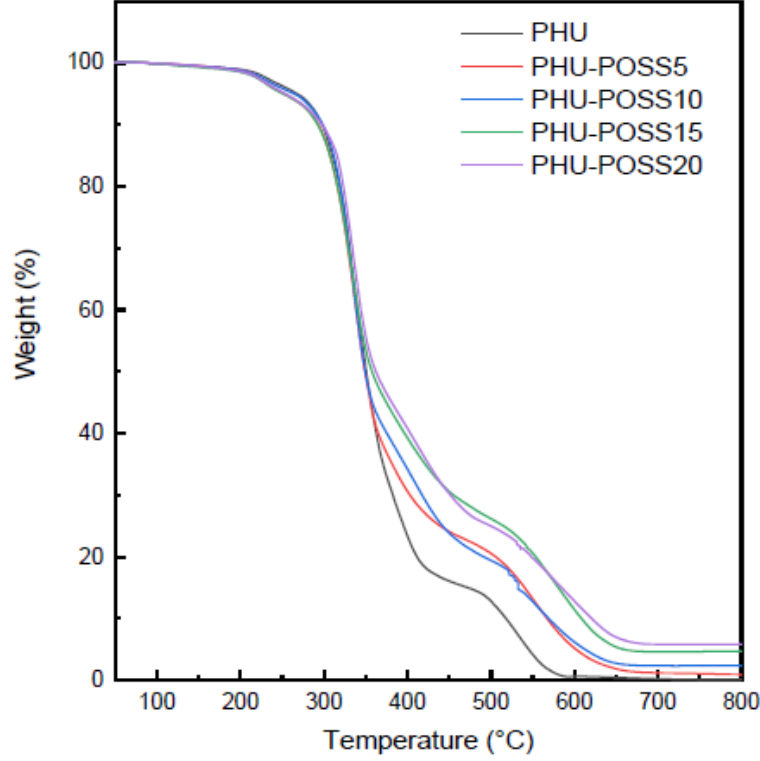
Figure 4. TGA curves of PHU and PHU-POSS nanocomposites.